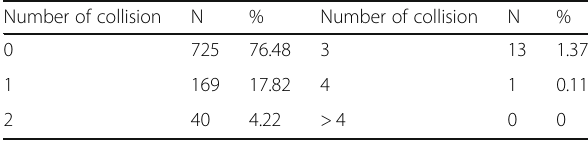
Table 1 Distribution of personal injury (PIN) collisions among taxi drivers surveyed Number of collision